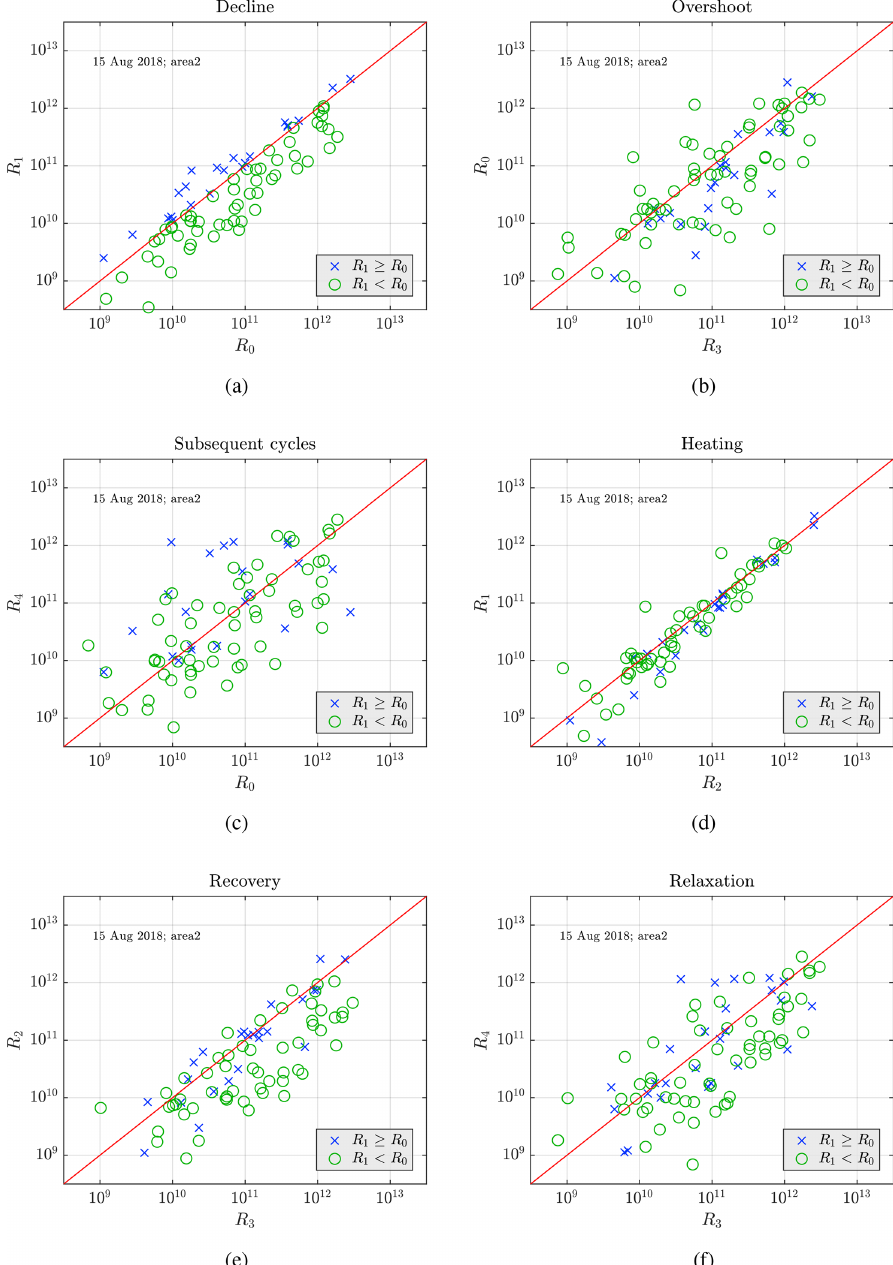
Figure 11. Comparison of the power amplitudes observed on the 15 August 2018 in area